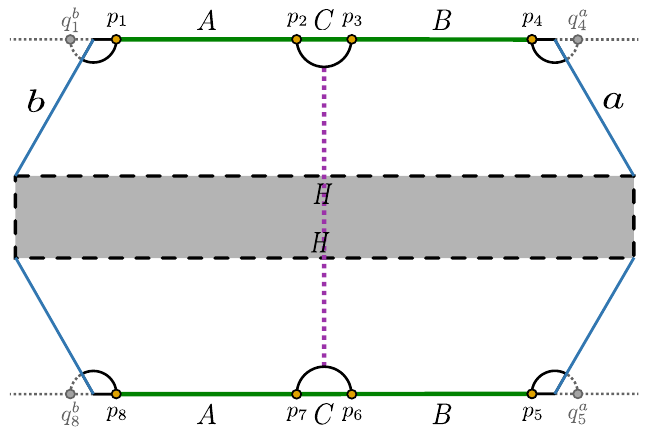
Figure 22 . The endpoints of the intervals A and B and the image points in the two BCFT 2 copies are identified similarly as in figure